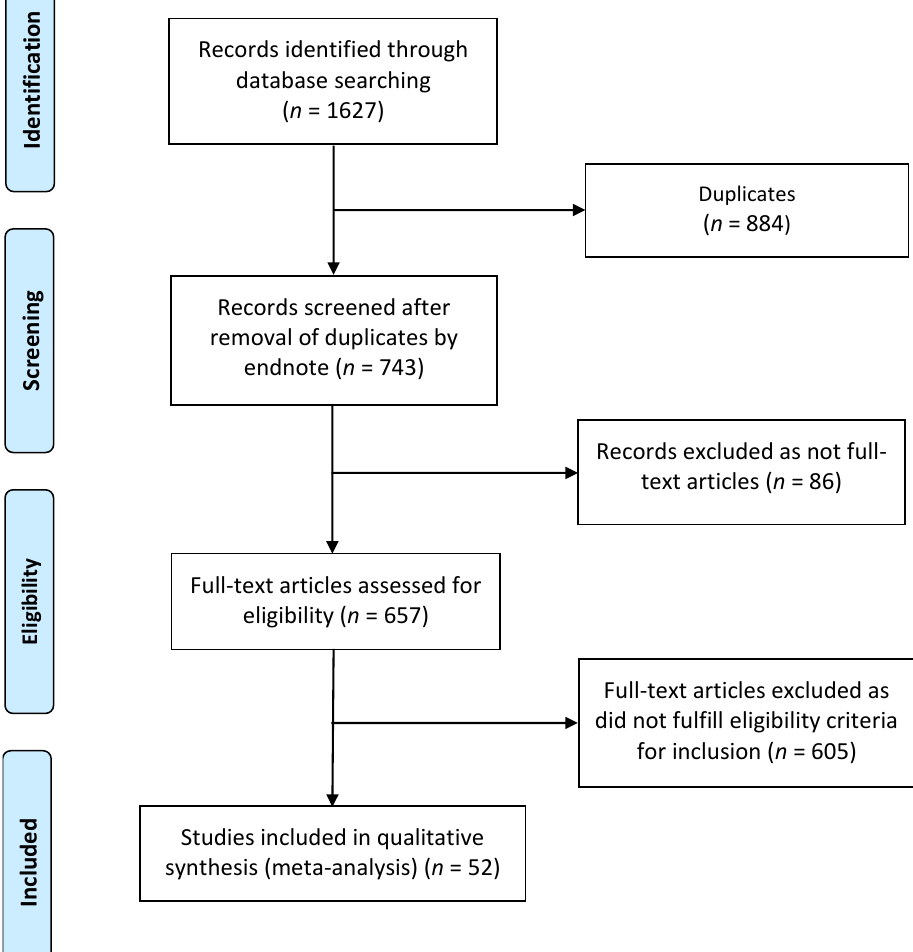
Figure 2. Flow diagram of literature search and data extraction from studies included in the systematic review and meta-analysis.